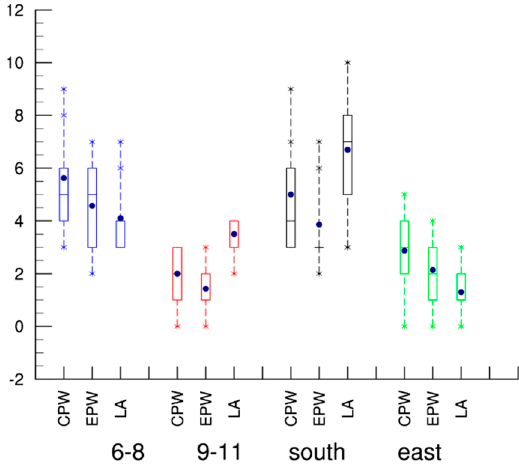
Figure 5. Same as in Figure 3, but for frequency (number) of TCs making landfall.